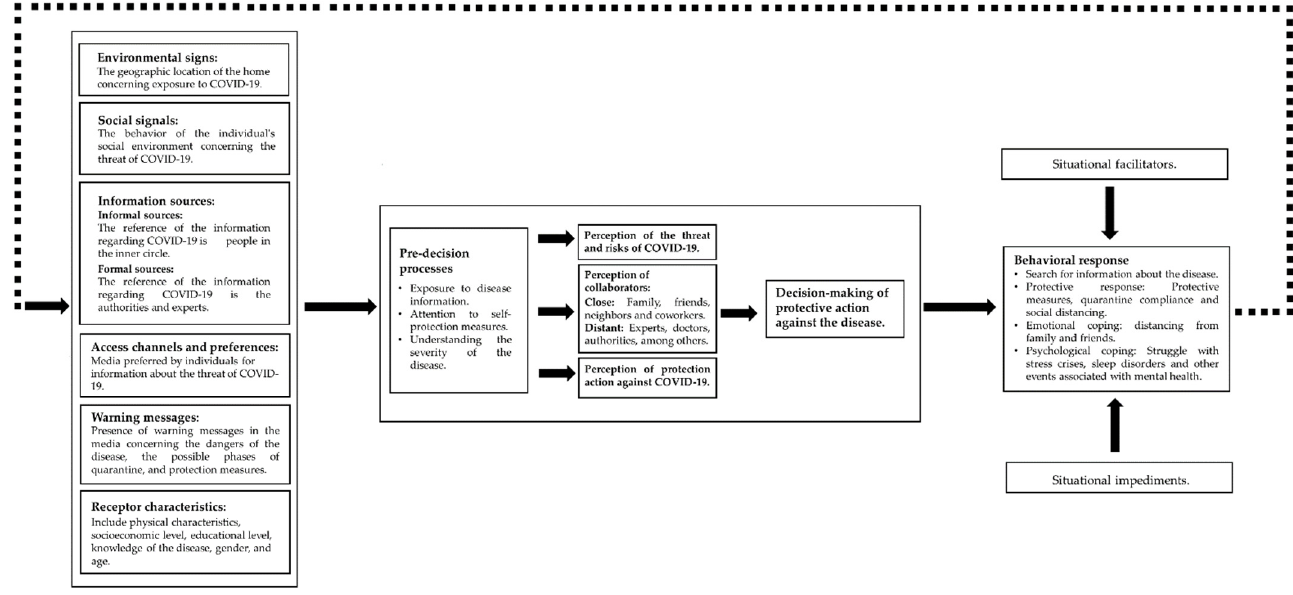
Figure 3. Application of the model to the situation of protective decision-making in the case of COVID-19.